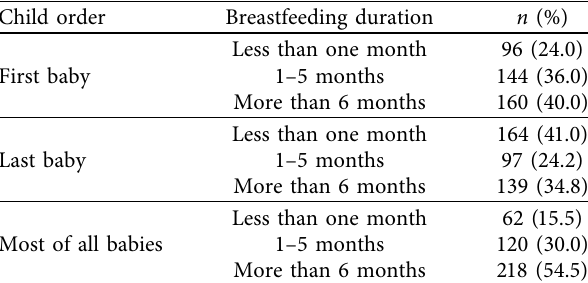
Table 2: Distribution of the study participants by the duration of exclusive breastfeeding ( n �